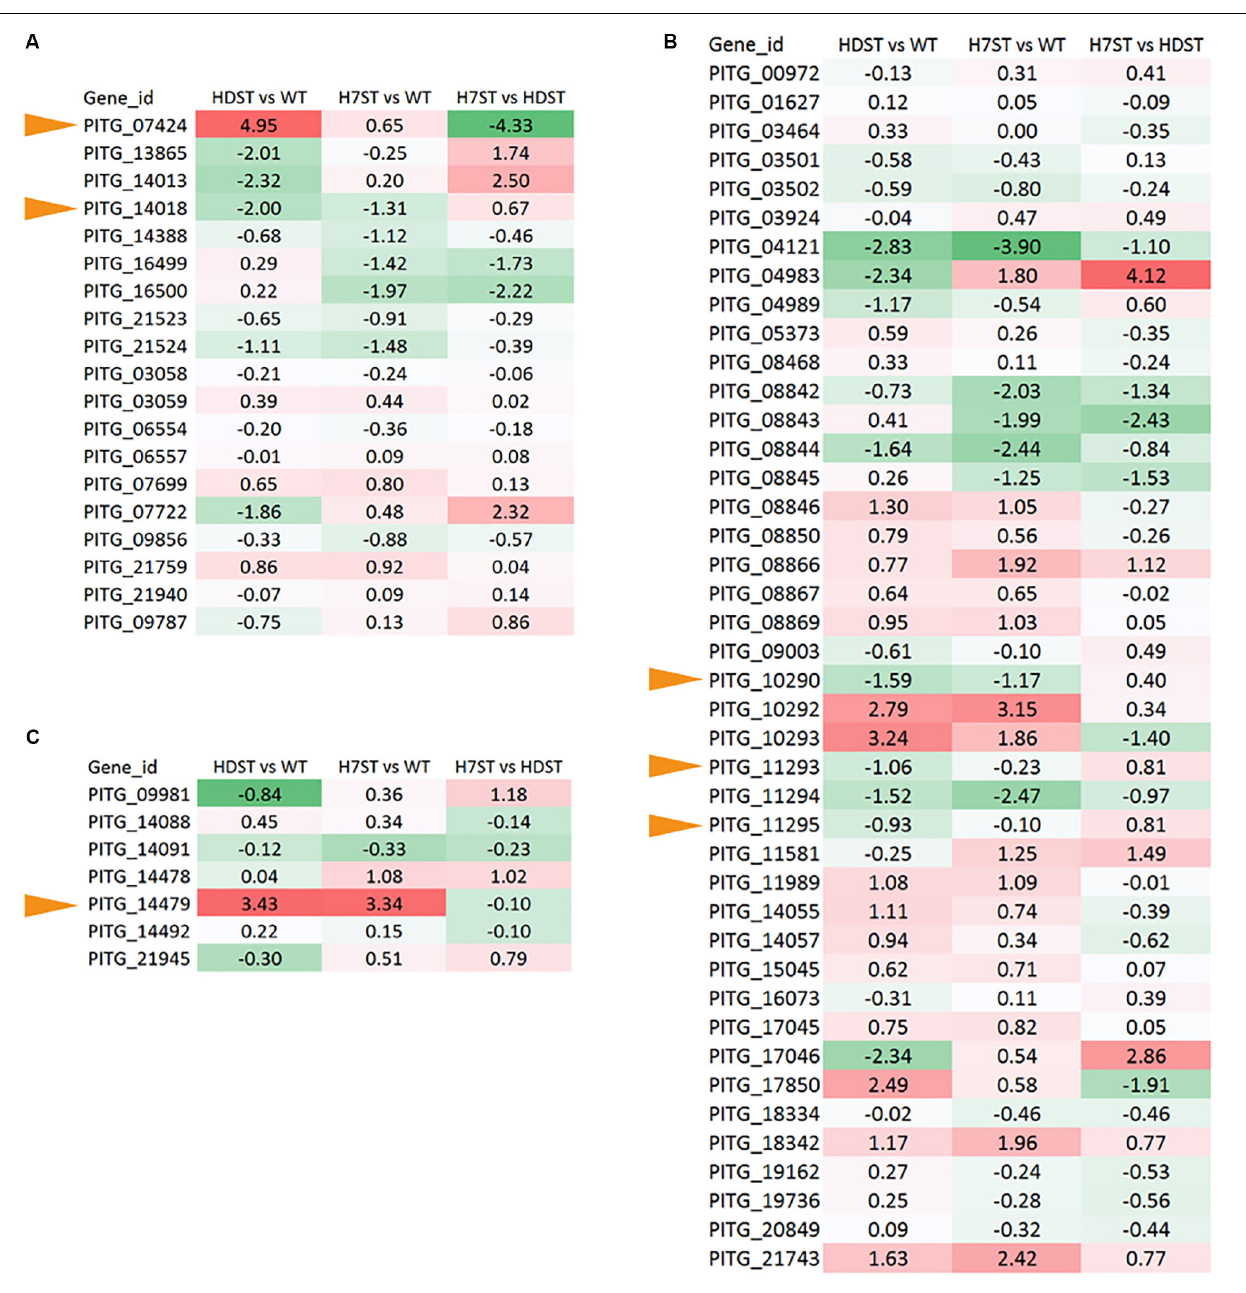
FIGURE 7 | Expression-level differences of genes encoding (A) cytochrome P450, (B) ADH, and (C) 2-coumarate reductase, which alter hormone chemical groups. Red and green denote genes with up- and down-regulated expression levels, respectively. The numbers represent the log 2 (fold-change) values. Yellow arrows represent the hormone synthesis related